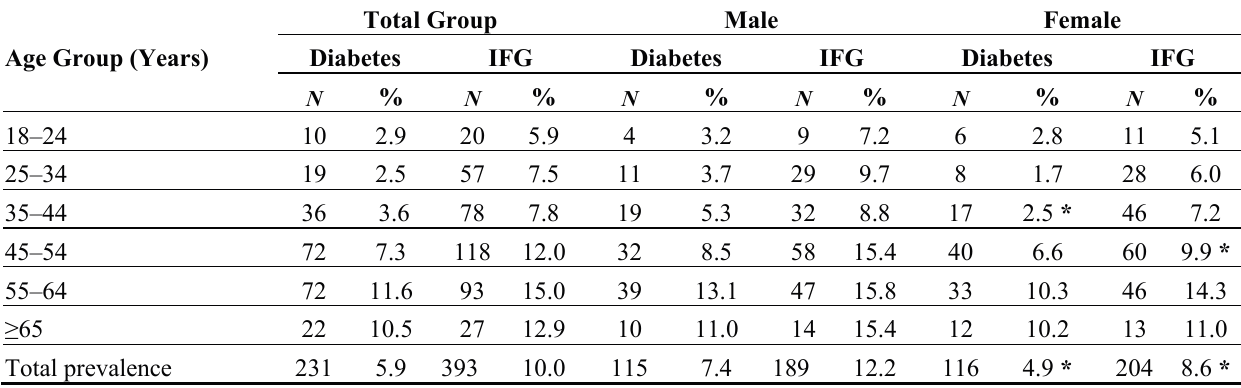
Table 2. Prevalence of diabetes and impaired fasting glucose (IFG) by gender in Kazakh